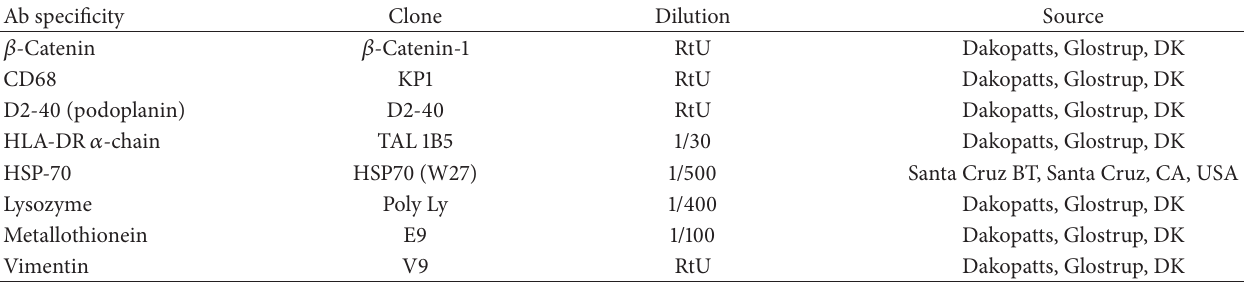
Table 1: Antibodies used to identify structural features of synovial membrane.